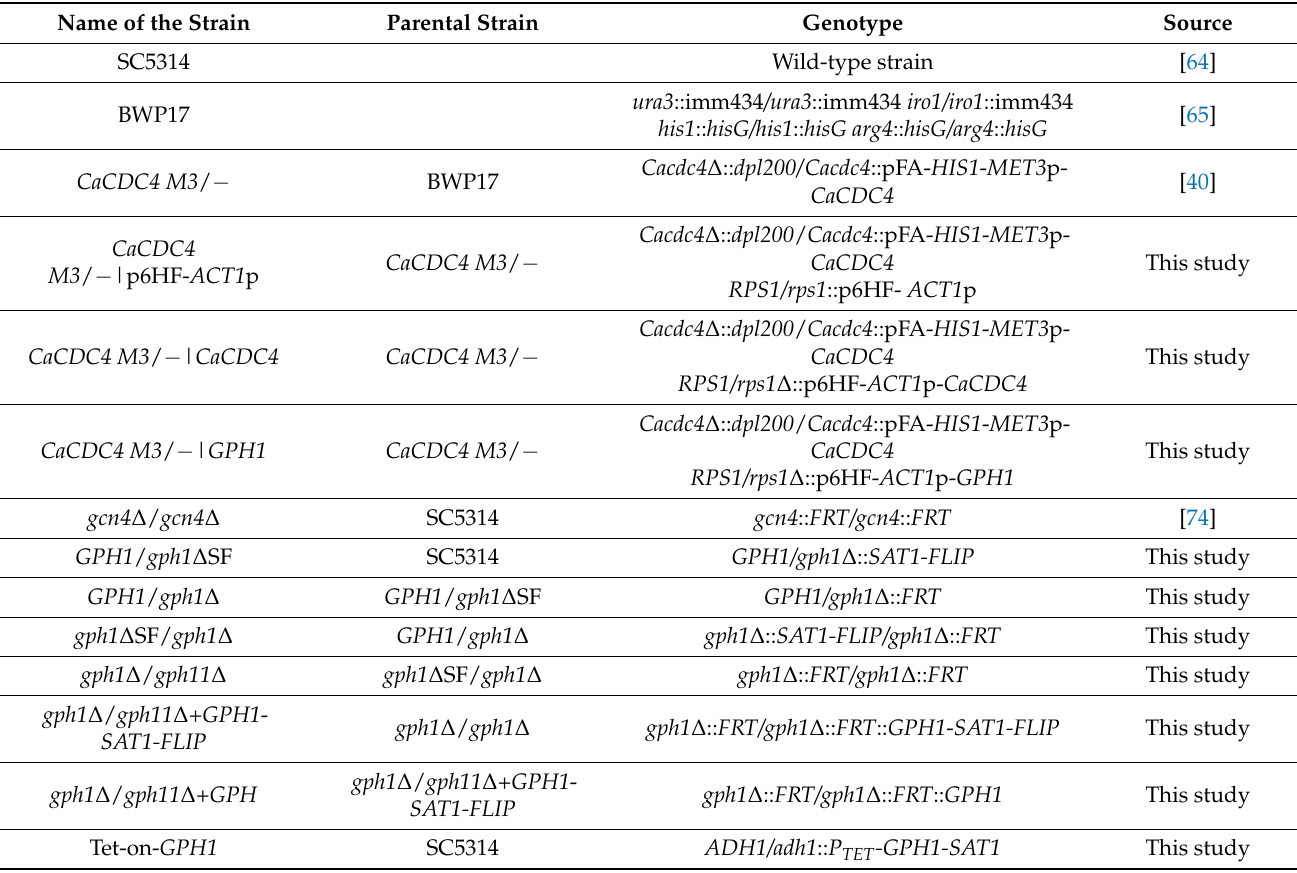
Table 1. Candida albicans strains used in this study.